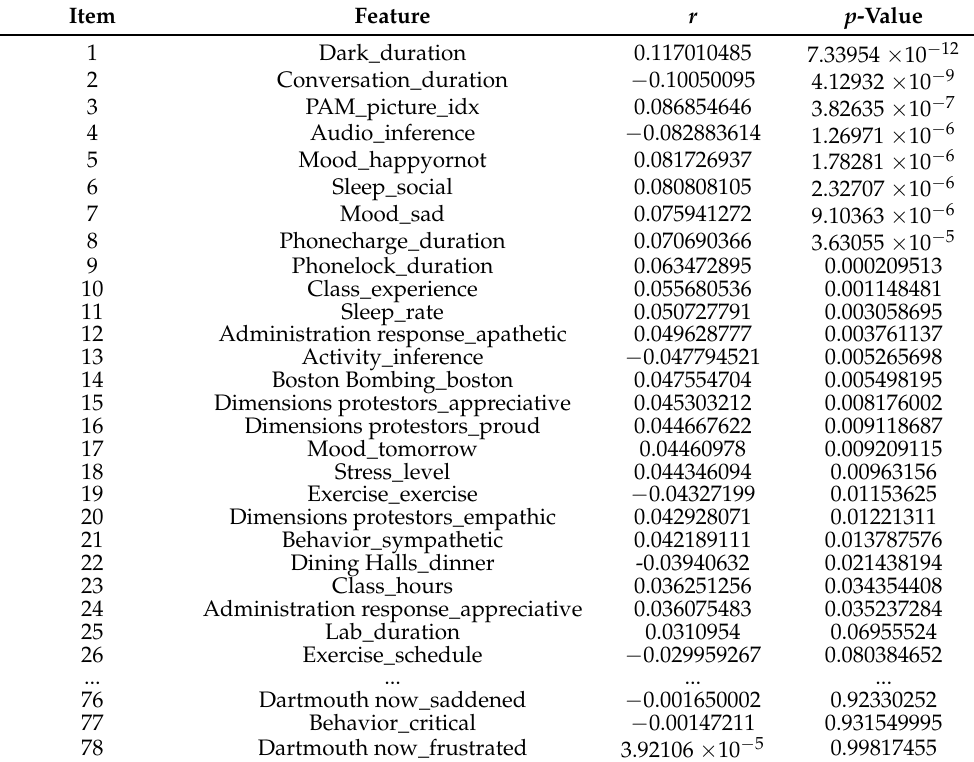
Table 2. Pearson correlation